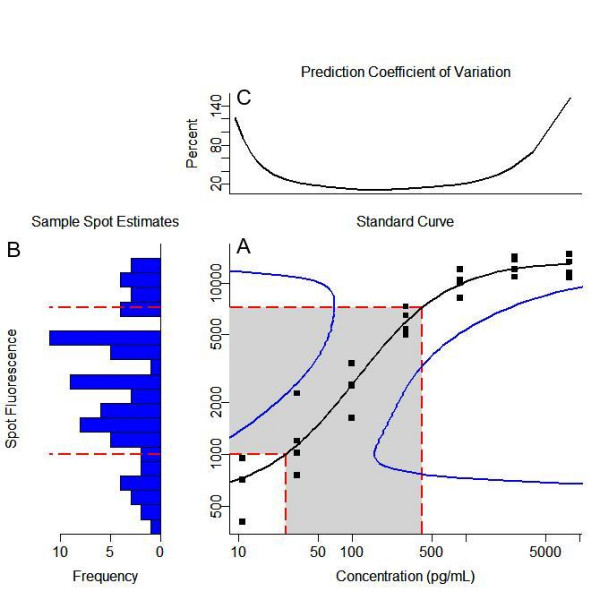
Three-panel diagnostic summary The standard curve panel (A) of the three-panel diagnostic summary features a scatterplot of the data, the estimated standard curve (black line), the 95% confidence intervals (blue lines), and the region of acceptable errors (grey). For this example, the acceptable segment of the standard curve (i.e., the segment with concentration estimation errors acceptable to us) covers spot intensities from about 1000 to 7500 intensity units and concentrations from about 25 to 500 pg/ml. The histogram of sample intensities (B) suggests that about one-fifth of the sample spot intensities is below the detection limit of about 1000 units, about three-fifths will produce estimated concentrations in the acceptable range, and one-fifth exceeds the acceptable range. With regard to remeasuring the standards in this experiment or imaging in future experiments, the three-panel graph suggests that it may be worthwhile to attempt to extend the acceptable range. It also suggests that the normalization between the standards measurements and sample measurements should be revisited. The graph of the concentration coefficient of variation as function of concentration (C) offers an alternative summary of the estimation errors over the range of concentrations.